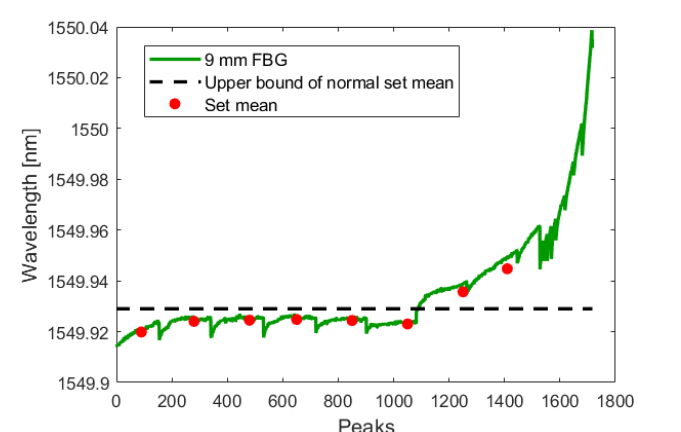
Figure 20. Crack detection analysis during high-amplitude cyclic loading for the FBG embedded 9 mm from the notch